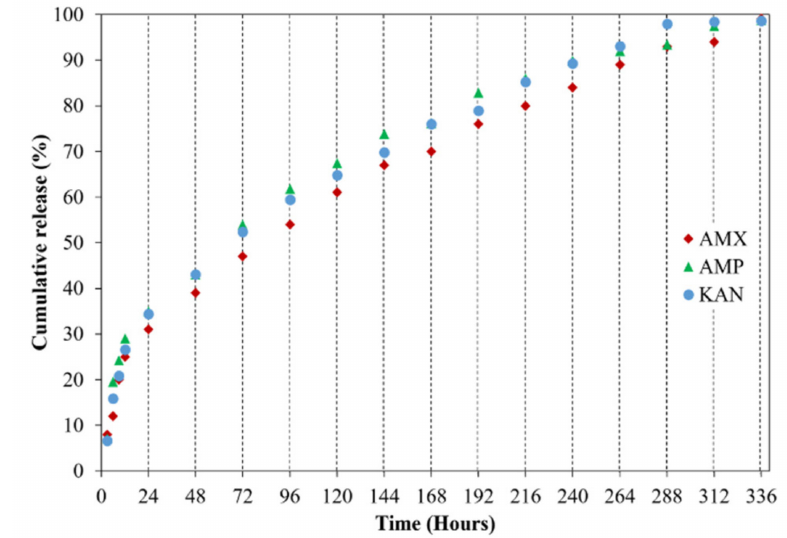
Figure 8. Cumulative release (%) of loaded antibiotic